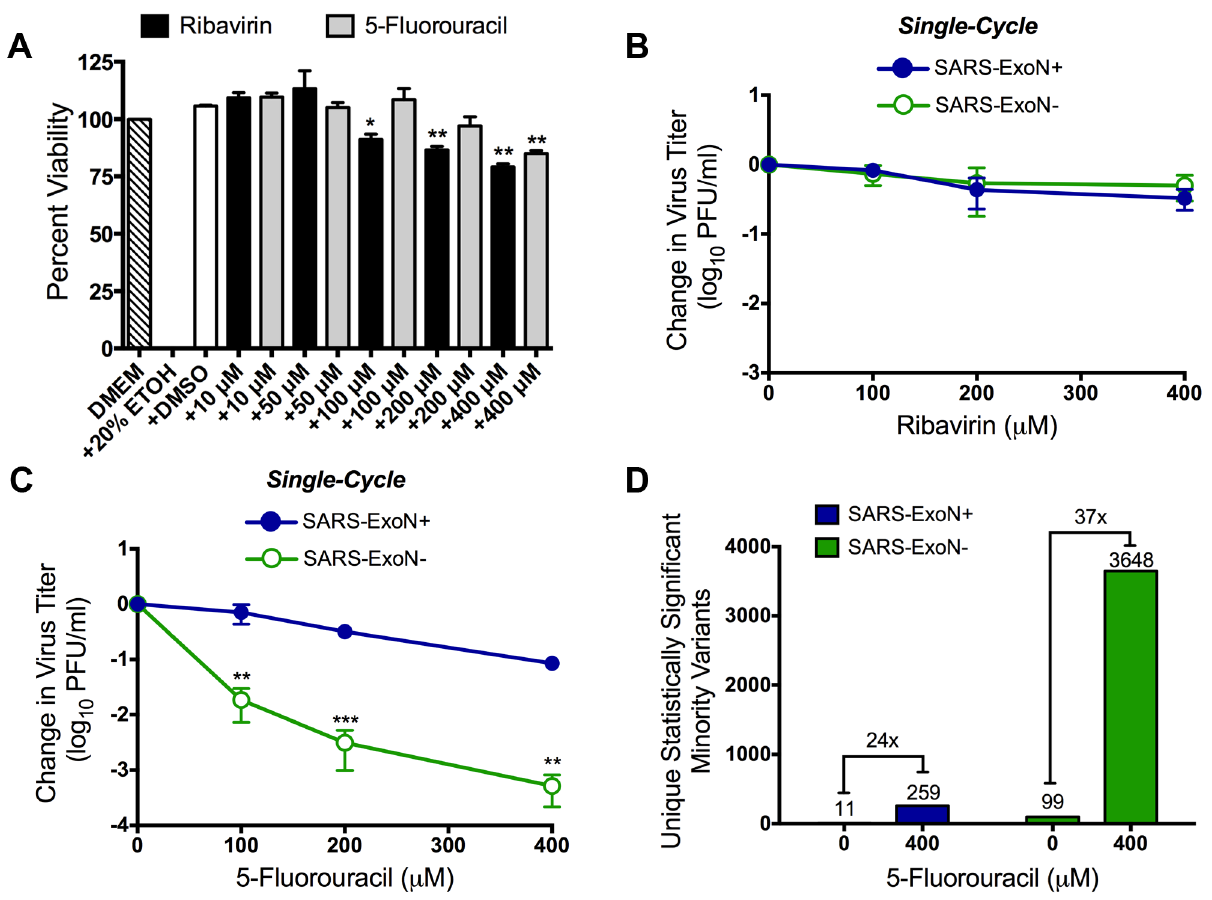
Figure 3. SARS-ExoN 2 viruses have increased sensitivity to 5-FU. ( A ) Vero cells in 96-well plates were incubated with DMEM alone, or DMEM containing 20% ethanol (EtOH), 4% DMSO, or the indicated concentration of RBV or 5-FU for 24 h. Cell viability was determined using CellTiter-Glo (Promega) according to manufacturer’s instructions. All values were normalized to the untreated (DMEM) control. Mean values 6 S.E.M. are shown, n=3. The change in SARS-ExoN + (filled blue circles) and SARS-ExoN 2 (empty green circles) titers following treatment with RBV ( B ) or 5-FU ( C ) during single-cycle replication. Vero cells were infected with either virus at an MOI of 0.1 PFU/cell, and virus supernatant was harvest 24 h post-infection following replication in the presence or absence of RBV or 5-FU. Virus titer was determined by plaque assay on Vero cells. Mean values 6 S.E.M. are shown, n=2 (RBV) and n=4 (5-FU). ( D ) Comparison of unique statistically significant (P , 0.05) minority variants present between untreated and 5-FU treated samples for both SARS-ExoN + and ExoN 2 populations. SARS-ExoN + viruses are shown in blue, and SARS-ExoN 2 viruses are shown in green. For panels A–C statistical significance was determined using an unpaired, two-tailed Student’s t test (*P , 0.05, **P , 0.01, ***P , 0.0001).